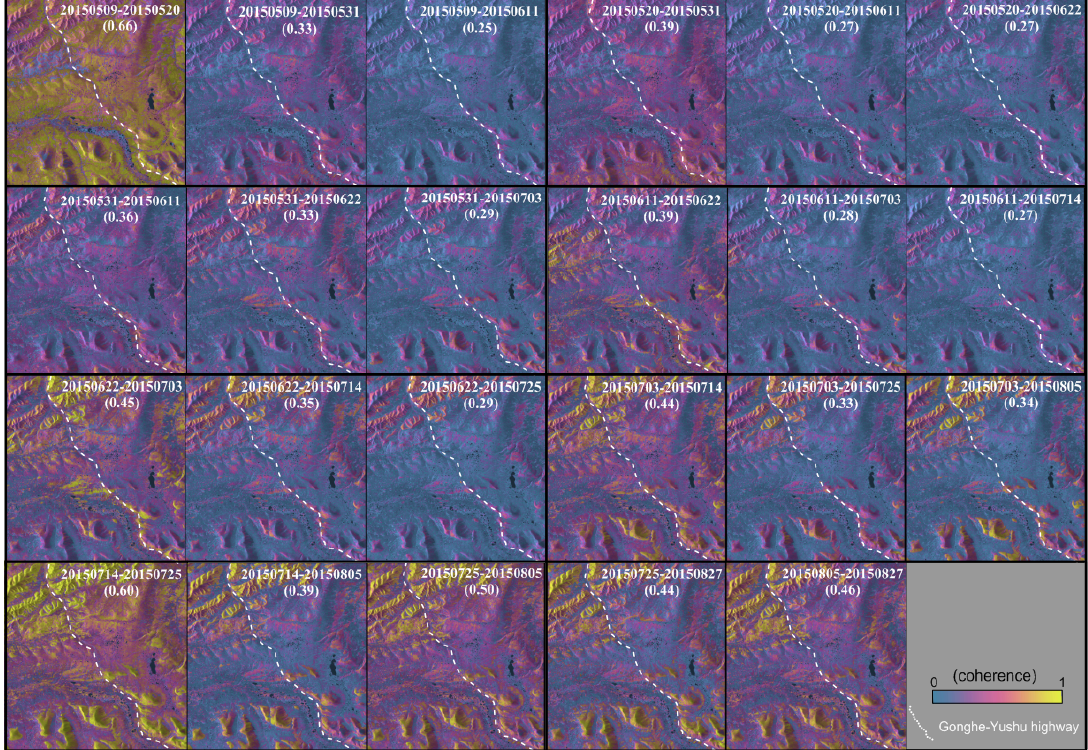
Figure 11. Coherence map of some interferometric pairs, imaginary line denote the G214 highway, (based on SAR pixel coordinate).